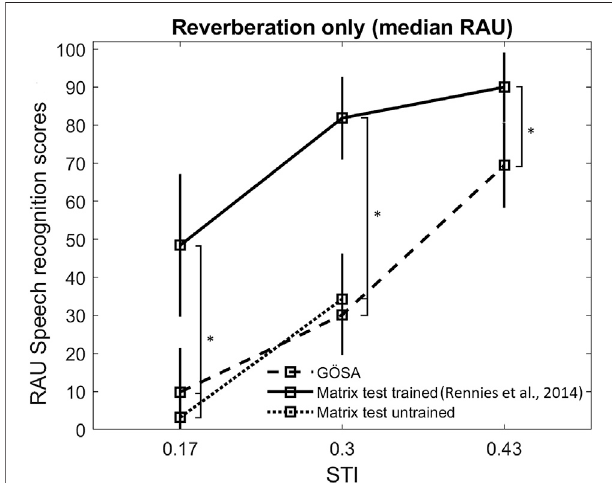
FIGURE 2 | Median RAU recognition scores and corresponding interquartilerangesforeverydaysentencetest(GÖSA),trainedGermanmatrix test (data from Rennies et al., 2014), and untrained German matrix test including only reverberation as detrimental factor. Stars indicate statistically signi fi cant differences across measurements conditions.